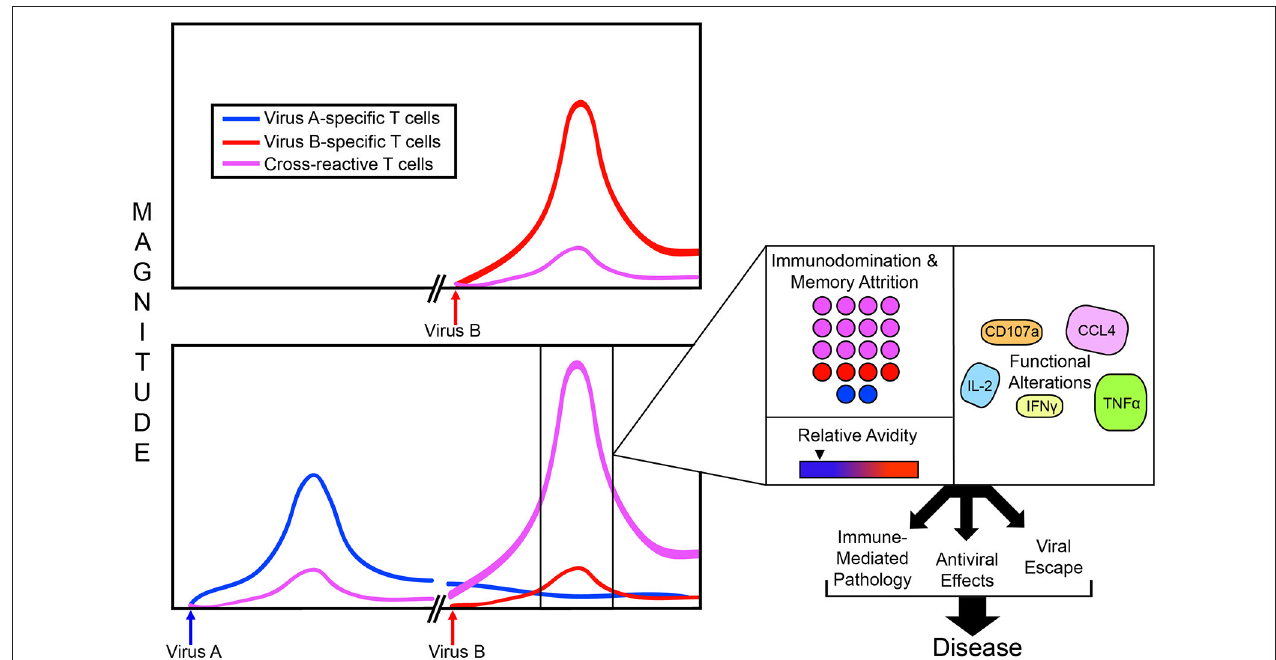
FIGURE 2 | Consequences of T cell cross-reactivity during heterologous infection. During a primary infection, (for example with Virus B), a diverse T cell response may be generated against multiple Virus-B-specific epitopes (Red) possibly in addition to some cross-reactive epitopes (Purple); both of which will contract to some degree following viral clearance. However, if an infection with Virus B is preceded by Virus A, and the two viruses share responses to the same cross-reactive epitopes, an altered T cell immunodominance hierarchy may occur during the heterologous infection. In this case, at the point of infection with Virus B, cross-reactive memory T cells generated during infection with Virus A are already present at a higher frequency and lower activation threshold than naïve T cells specific for Virus A. This can lead to a preferential expansion of the cross-reactive T cells often at the expense of the virus specific ones, or “immunodomination.” During this process, memory cells specific to Virus A can even be lost from memory attrition, potentially impacting protection from future infections with Virus A. Sometimes, T cell cross-reactivity can occur in the absence of neutralizing antibody cross-reactivity, resulting in higher antigen loads than what would normally be present in a homologous boosted infection (Virus B followed by Virus B) which can lead to profound T cell activation of a higher magnitude. In the case of some flaviviruses cross-reactive antibody can even increase antigen load via ADE. The preferentially expanded, cross-reactive T cells can display different avidity compared to those that would have been generated during an infection with Virus A in the absence of prior heterologous exposure. During a primary infection with Virus A, the cross-reactive population would normally have a stronger avidity to the peptide variant of Virus A. However, during a heterologous infection, they have a stronger avidity to the peptide variant of the prior infection, Virus B. T cell cross-reactivity during heterologous infection can even have functional implications for cross-reactive T cells, though the alterations to cytokine profiles and their consequences is often virus-specific. All of these alterations to T cell populations and their functional capacities will dictate the balance between cross-protection and immunopathology, and can even result in viral escape; The sum of these, ultimately defining the disease